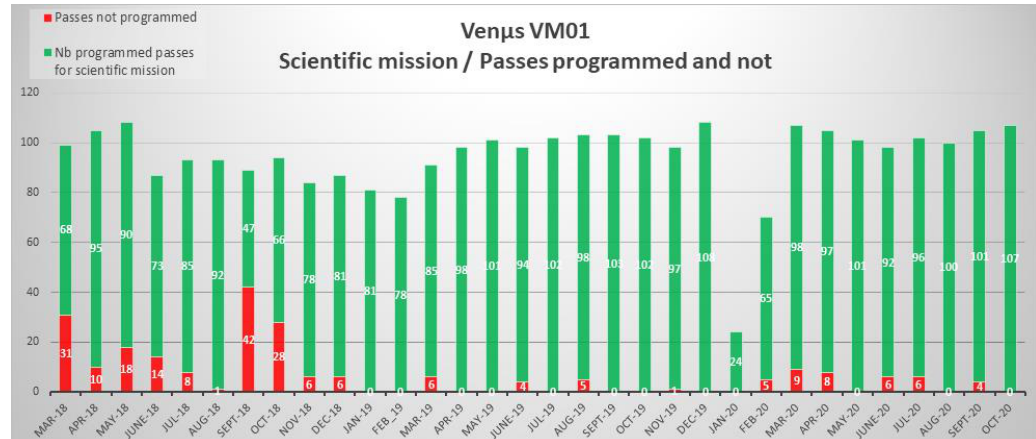
Figure 40. Statistics on Kiruna station programming.